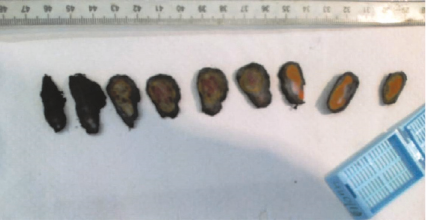
Figure 2: Sectioning of the specimen revealing a single well circumscribed nodular tissue.